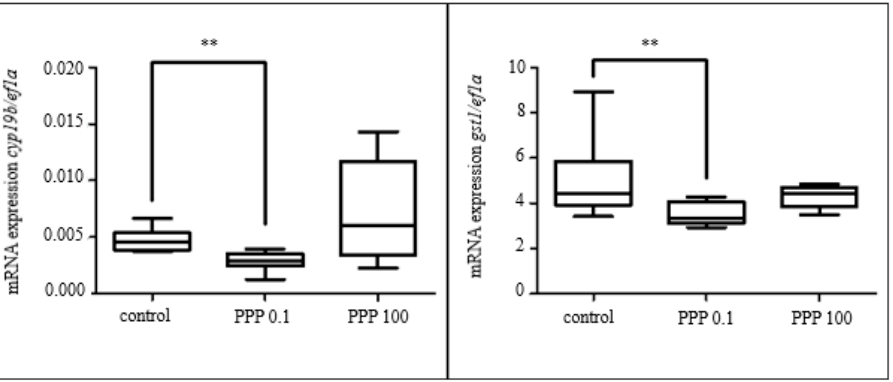
Figure 5. Relative mRNA expression of selected genes in C. carpio embryos exposed to PPP. Con- centrations are indicated in µg/L. Box plot graphs were constructed using median, Q1, and Q2 with whiskers of a maximum 1.5 interquartile range. Statistically signi fi cant di ff erences are indicated by ** ( p < 0.01).